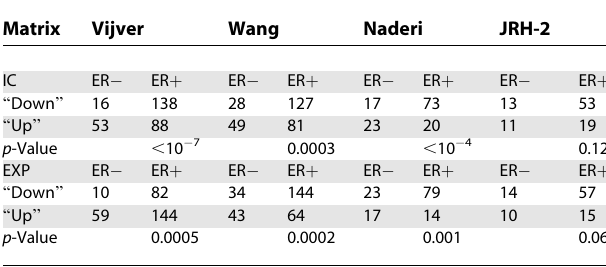
Table 2. Association of Immune Response with